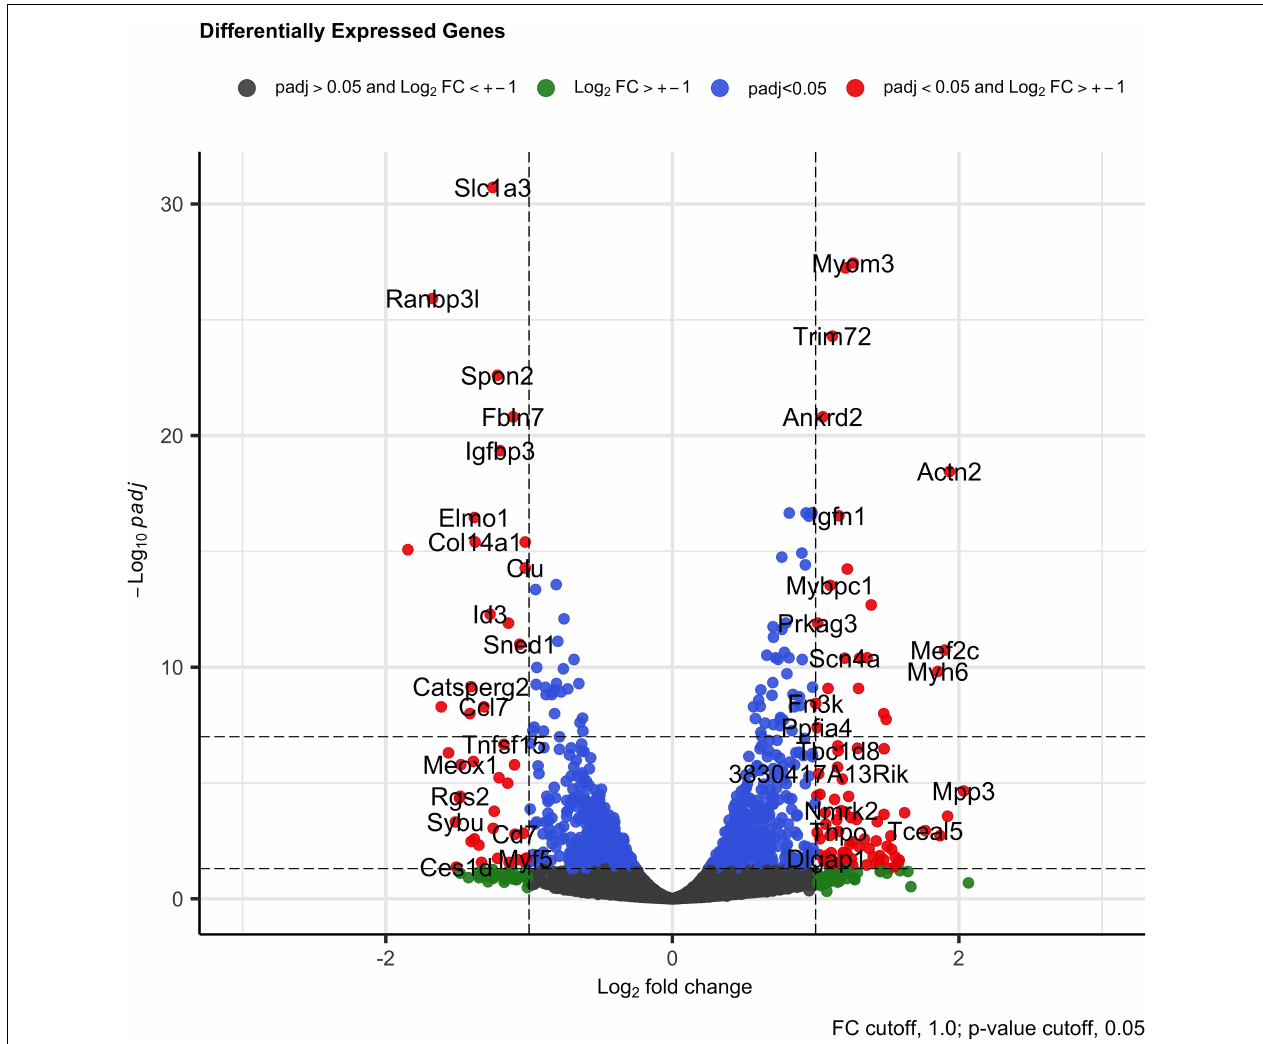
FIGURE 3 | Volcano plot representing all genes with log2 fold change bigger than 1.0 and significant ( p < 0.05) in the DE gene analysis in C2C12 cells after 3 days in differentiation medium. The red dots are the DE genes with log2 fold change higher than 1.0 in both sides (downregulated and upregulated) and with adjusted p -value <